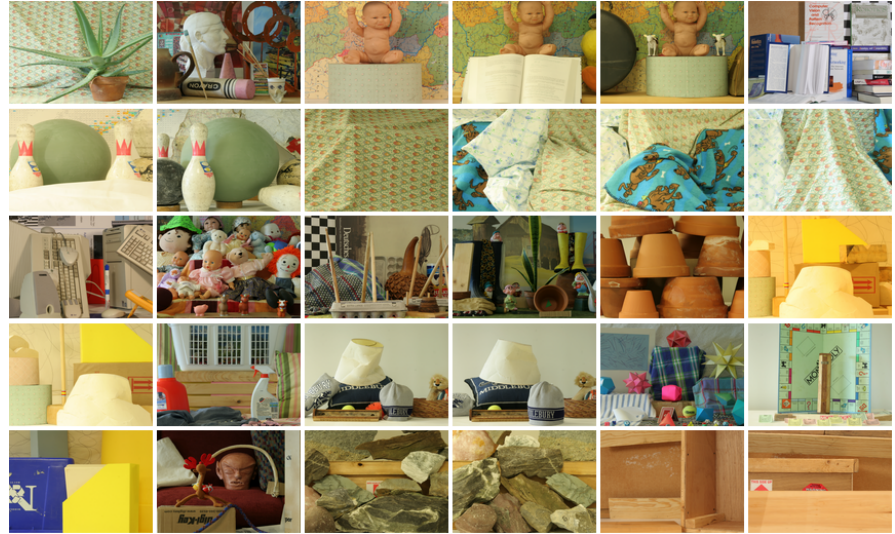
Figure 7. 30 image pairs from Middlebury 2005 and 2006 datasets (only left images are shown).